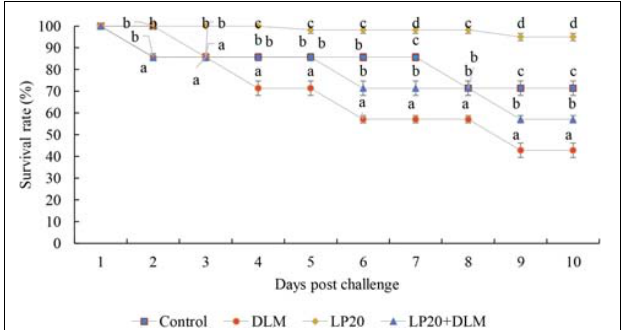
FIGURE 1 | The survival rate of Nile tilapia exposed to DLM and challenged with Aeromonas hydrophila and fed diets with or without LP20 for 30 days. The survival rate was calculated according to the Kaplan–Meier method on a daily basis until the 10th day post challenge and expressed as mean ± SE from triplicate groups. Different letters on each period indicate significant difference P <